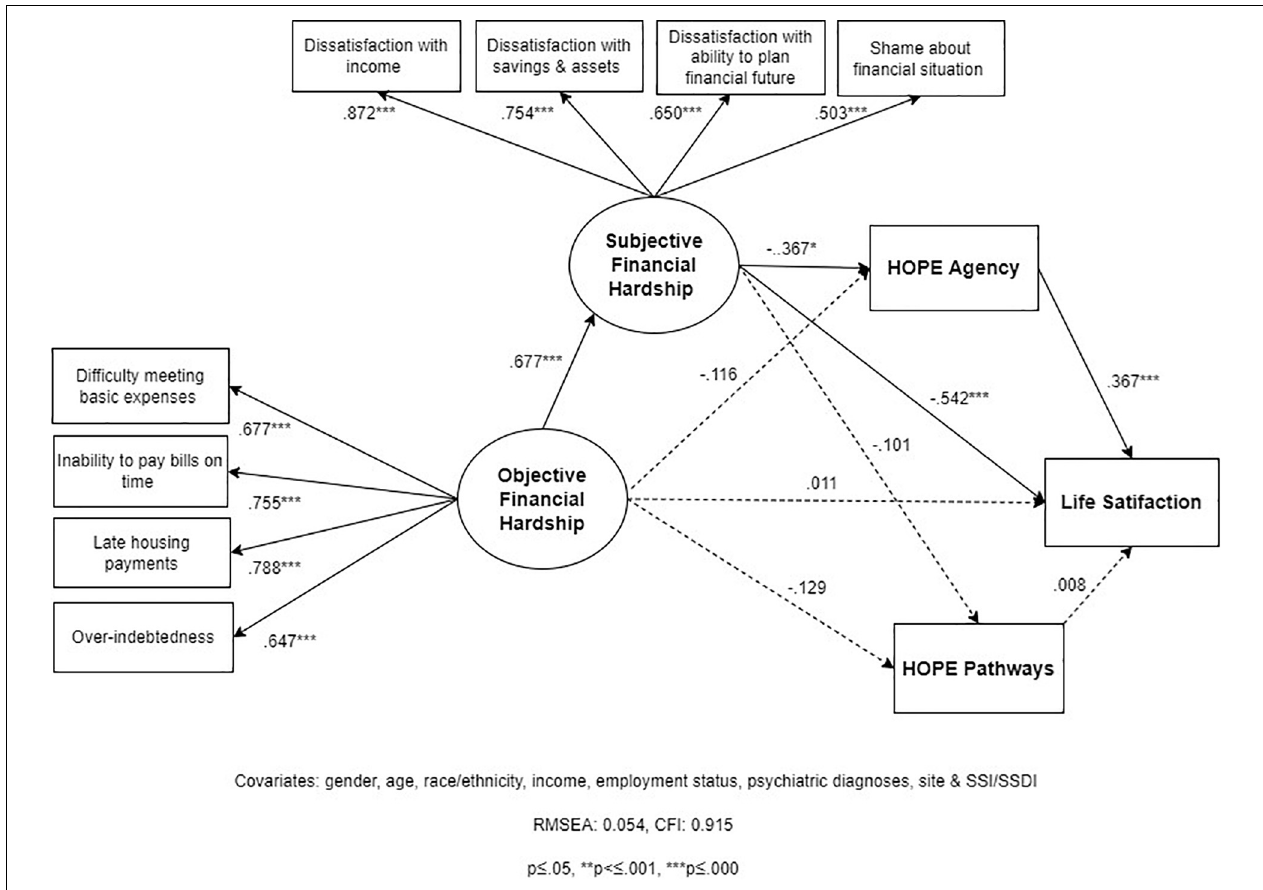
FIGURE 4 | Structural Equation Model 3 (SEM 3): relationships between objective financial hardship (OFH), subjective financial hardship (SFH), hope agency, hope pathways, and life satisfaction (LS; N =